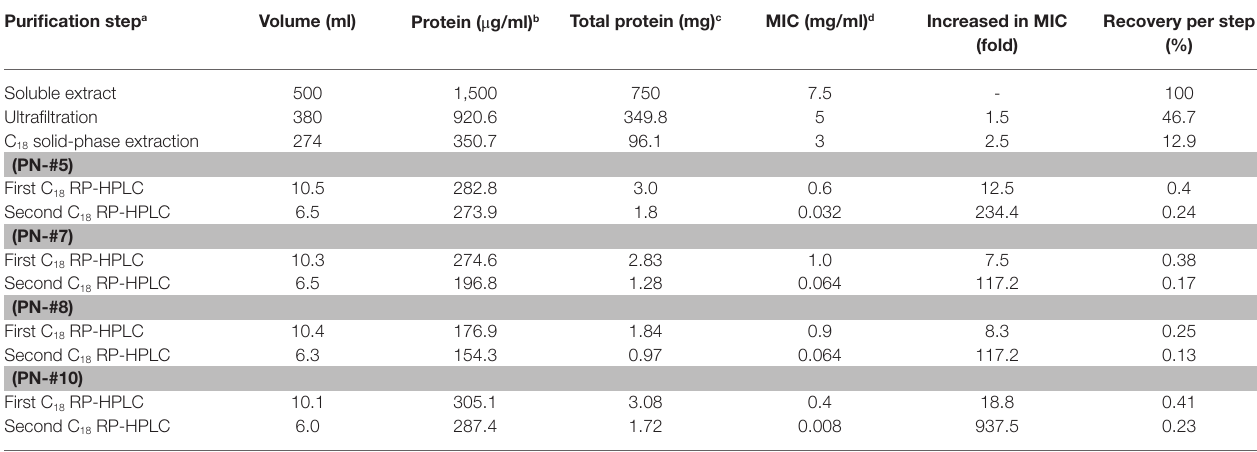
TABLE 1 | Purification scheme for AMPs from water-soluble extract of pine